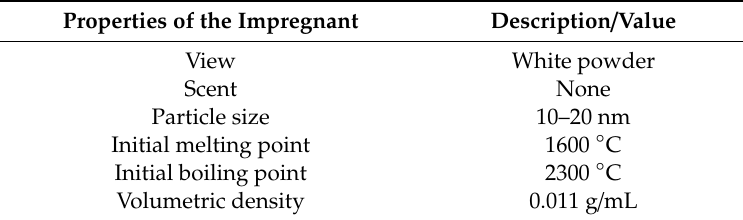
Table 1. Detailed physical and chemical properties of SiO 2 flame retardant